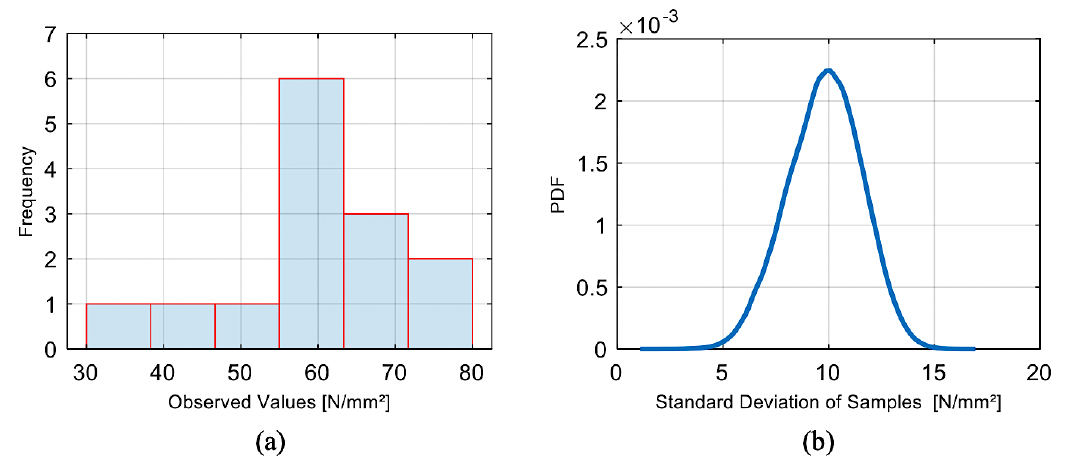
Figure 2. (a) Histogram of the observed concrete strength values (b) Kernel density estimation of the standard deviation of the bootstrap samples as statistical scatter